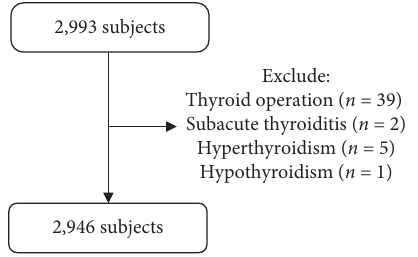
Figure 1: Flowchart of this